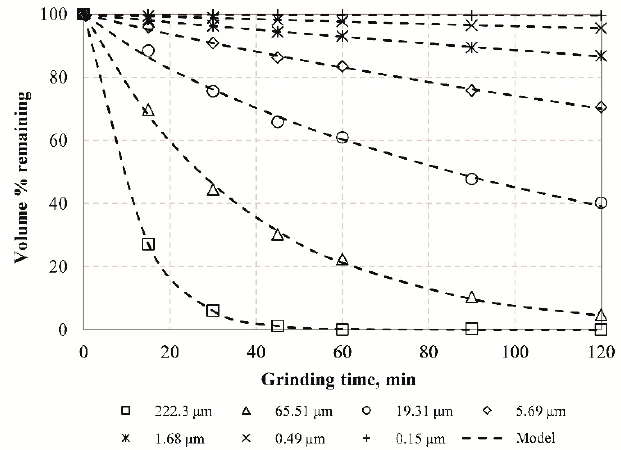
Figure 3. Remaining fraction (% volume) for seven representative sizes vs. grinding time. Table 3. Parameters of Alyavdin formula (Equation (2)) for seven representative sizes (mm). Parameter